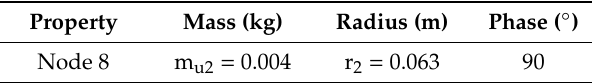
Table 3. The parameters of the imbalance